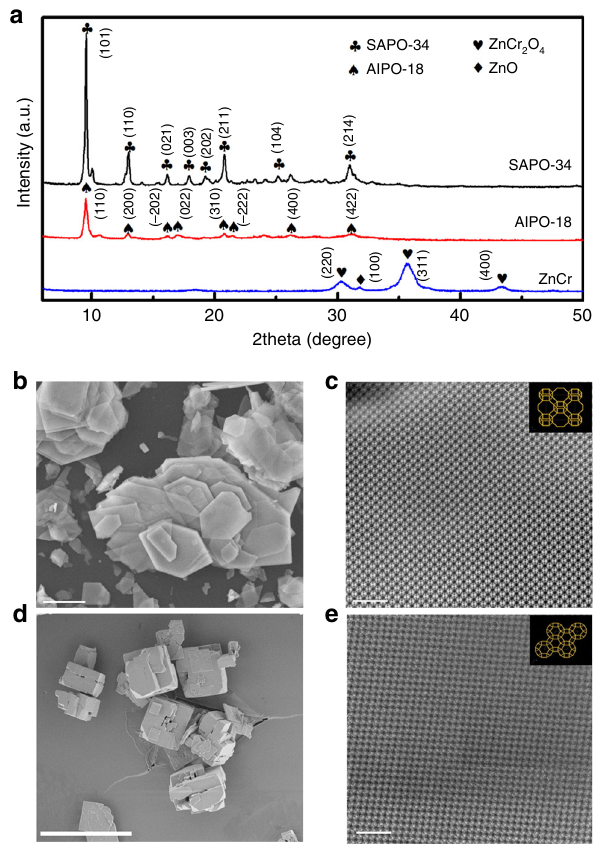
Fig. 1 Microstructure of bifunctional catalysts. a XRD patterns of the calcined ZnCrO x , AlPO-18 and SAPO-34 zeolites, SAPO-34(club), AlPO-18 (spade), ZnCr 2 O 4 (heart), and ZnO(diamond). b SEM images of the calcined AlPO-18 (scale bar, 1 μ m). c Aberration-corrected STEM images and the corresponding framework images of the calcined AlPO-18 (scale bar, 5 nm). d SEM images of the calcined SAPO-34 (scale bar, 10 μ m). e Aberration-corrected STEM images and the corresponding framework images of the calcined SAPO-34 (scale bar, 5 nm)